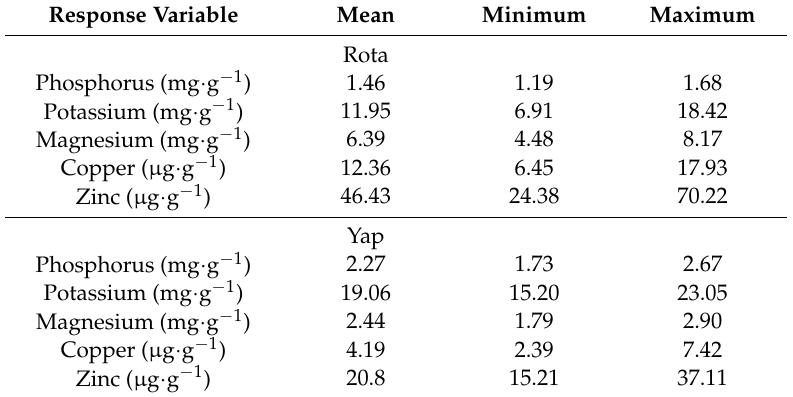
Table 3. Green leaf elemental response variables that were not influenced by Cycas micronesica tree height in Rota karst soils or Yap schist soils.